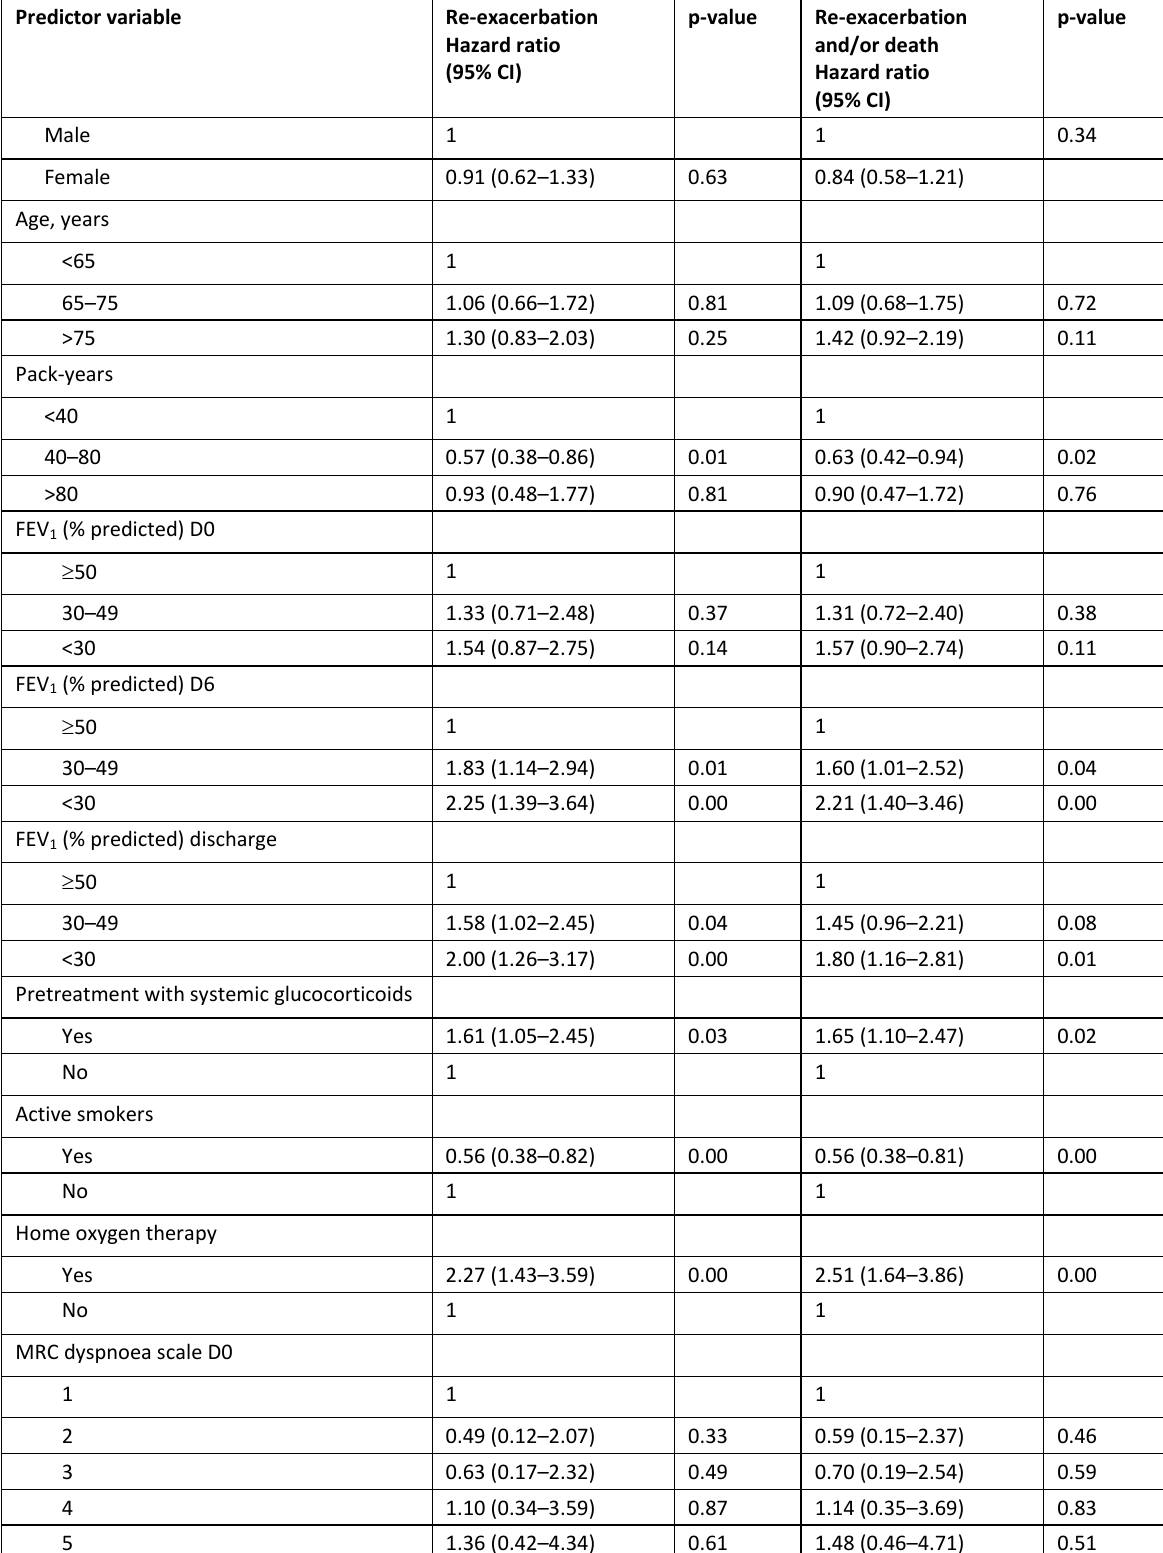
Table 2: Bivariate analyses of potential predictor variables of time to re-exacerbation or re-exacerbation and/or death. Predictor